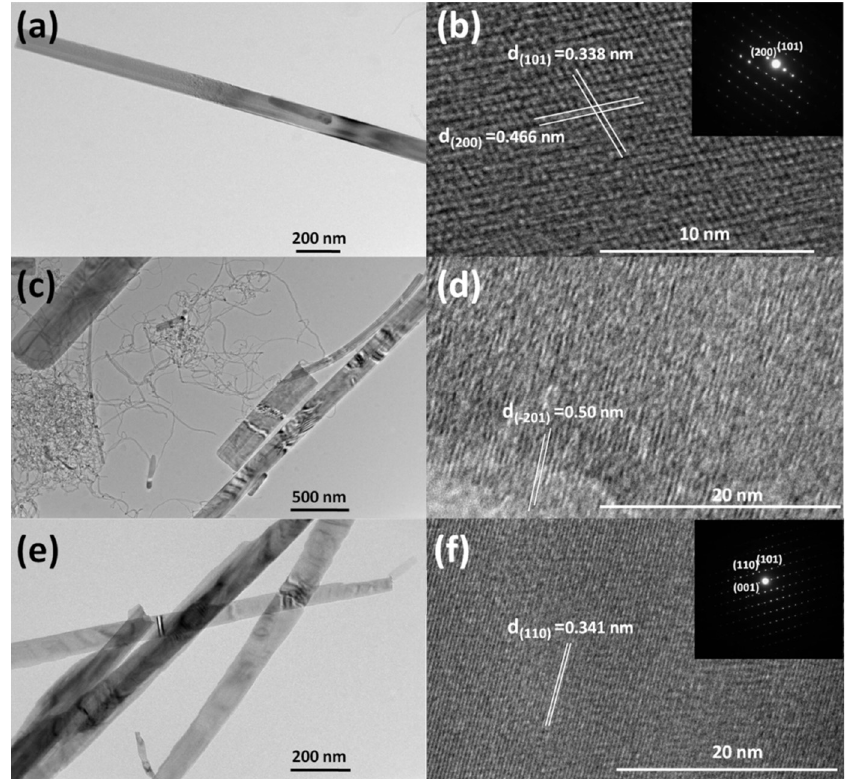
Figure 4. TEM and HRTEM images of V 3 O 7 · H 2 O NBs ( a , b ), VO 2 (B) NBs / MWCNTs ( c , d ) and V 2 O 5 NBs ( e , f ); the insets in ( b ) and ( f ) show SAED patterns.